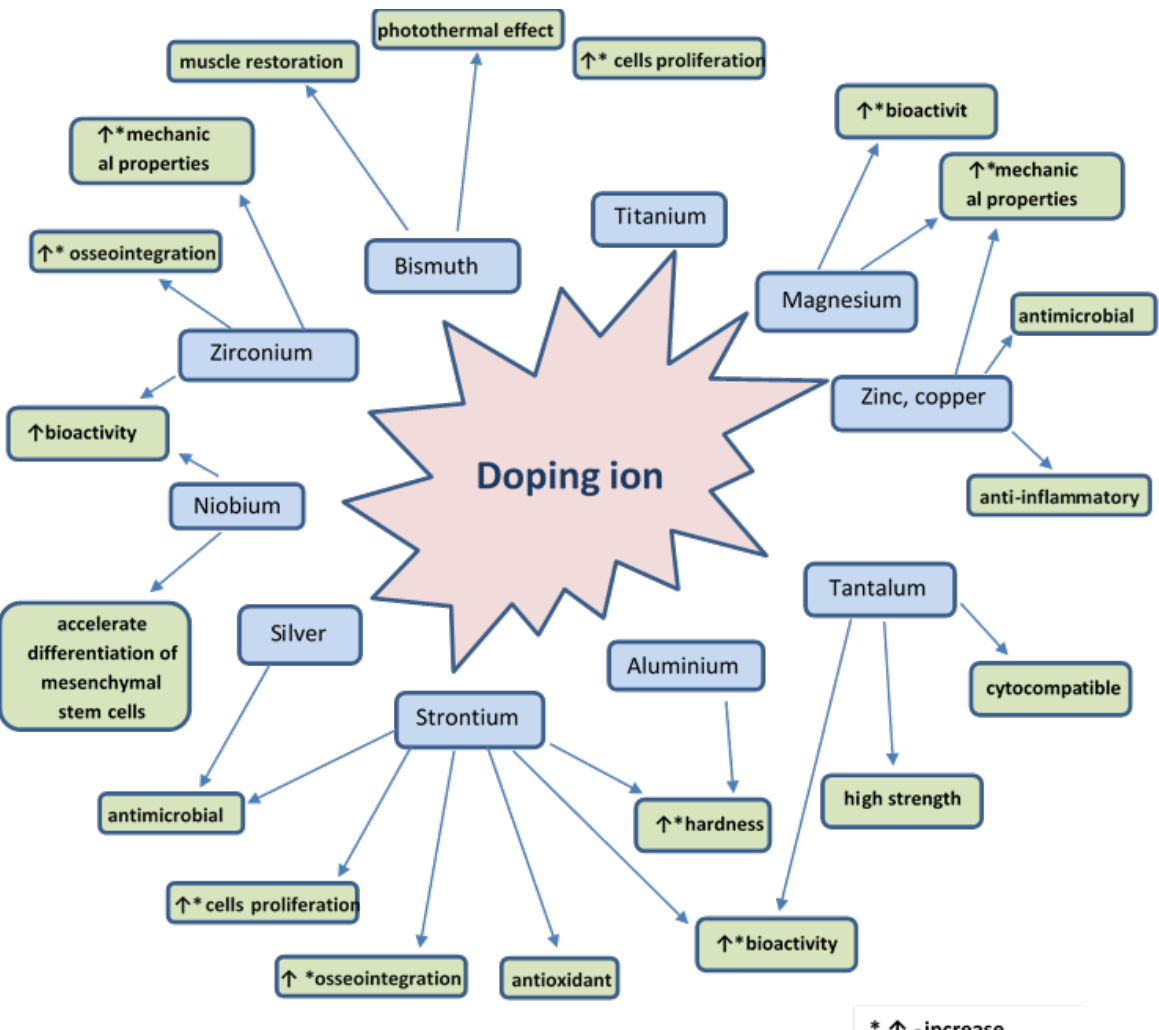
Figure 8. Schematic representation of the properties of bioactive glass given by several doping agents.